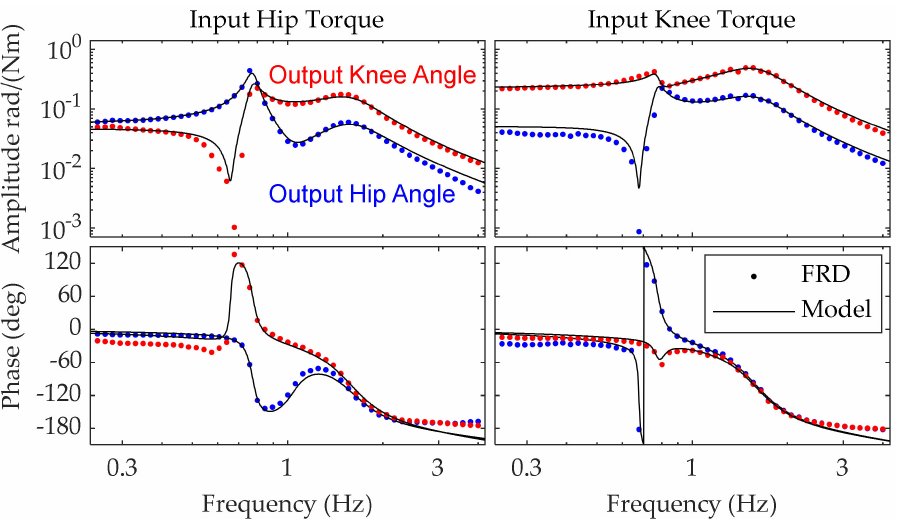
Figure 9. Frequency response data (FRD) and identified model from input torque to output position of the preliminary exoskeleton system on a prototype orthosis.